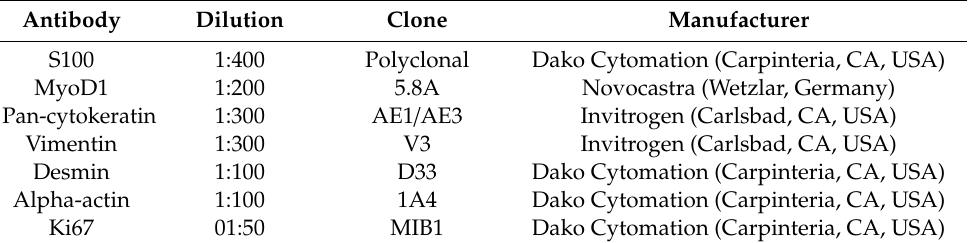
Table 1. Primary antibodies used for immunohistochemical analysis.